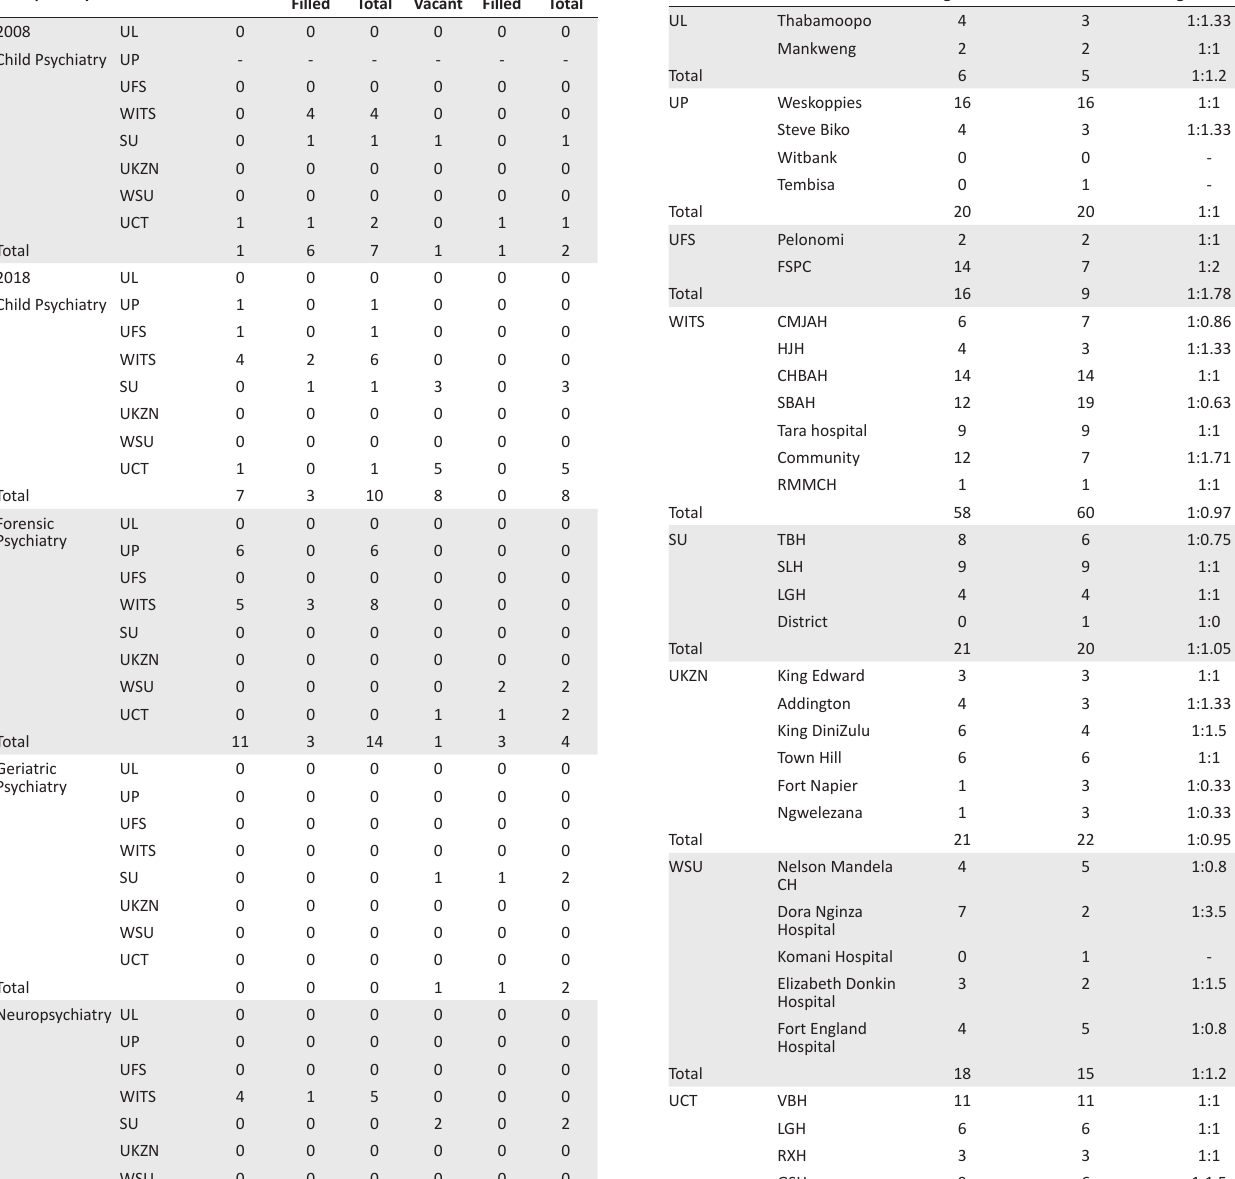
TABLE 2: Sub-specialist training posts. Year Sub-specialty